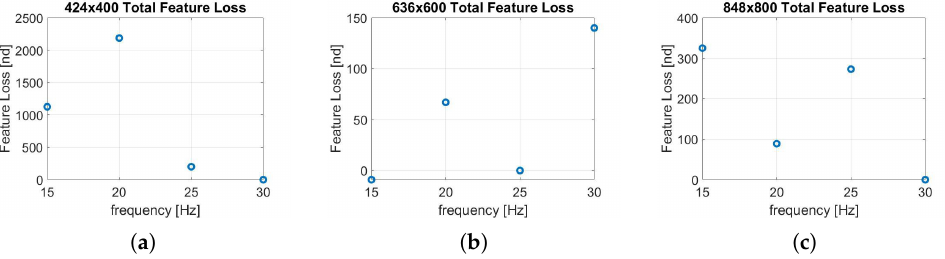
Figure 16. ( a ) FL, 424 × 400; ( b ) FL, 636 × 600; ( c ) FL, 848 × 800. Feature loss analysis along the trajectory performed by varying